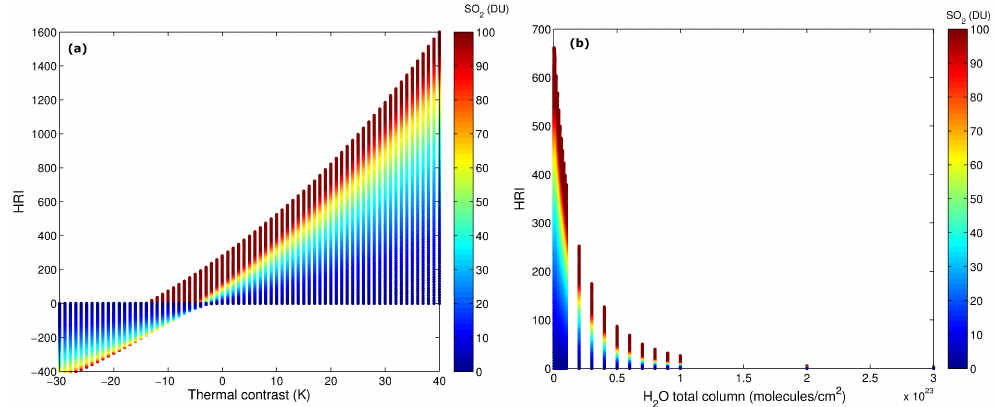
Figure 2. Example of interpolated LUT to convert HRI in SO 2 column depending on thermal contrast and water vapour for the angle bin 15–20 ◦ . The colour bar represents the 0–4km column of SO 2 in DU. Panel (a) shows the dependency of HRI on thermal contrast (constant total column of H 2 O of 2 × 10 20 moleculescm − 2 ); panel (b) shows the dependency on the total column of water (constant thermal contrast of 15K).